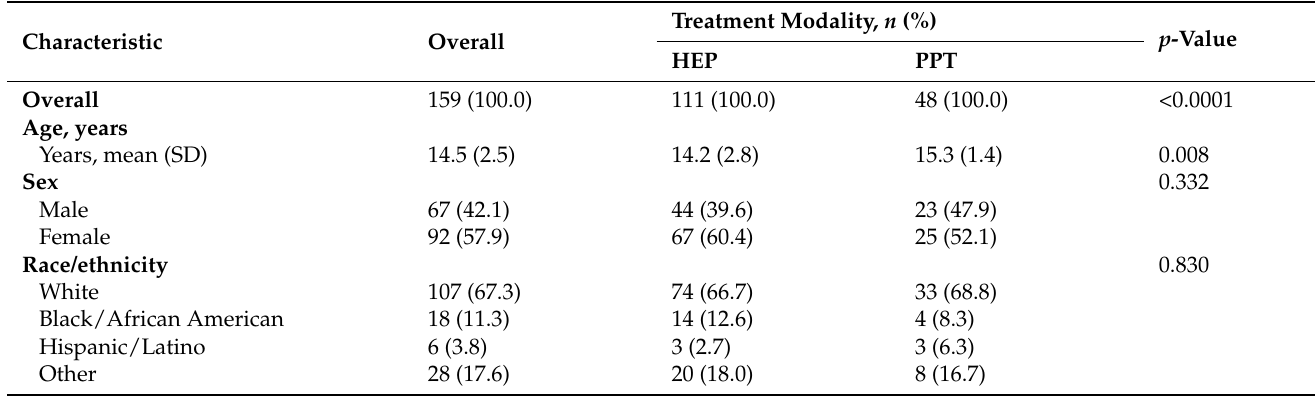
Table 1. Descriptive statistics on a sample of pediatric patients presenting to a specialty sport-related concussion clinic and subsequently experiencing a protracted recovery ( ≥ 28 days) by treatment modality,